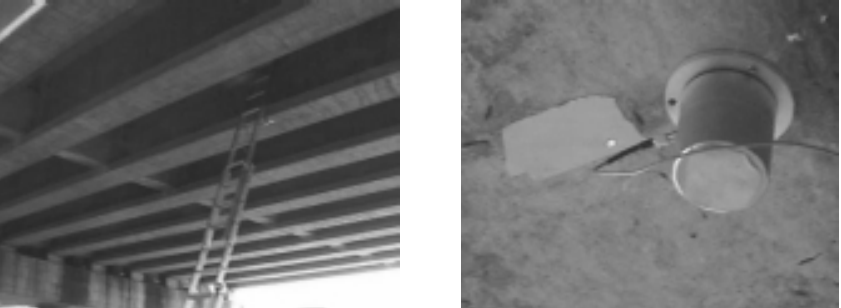
Fig. 3. The lower deck of the bridge and the measurement point.